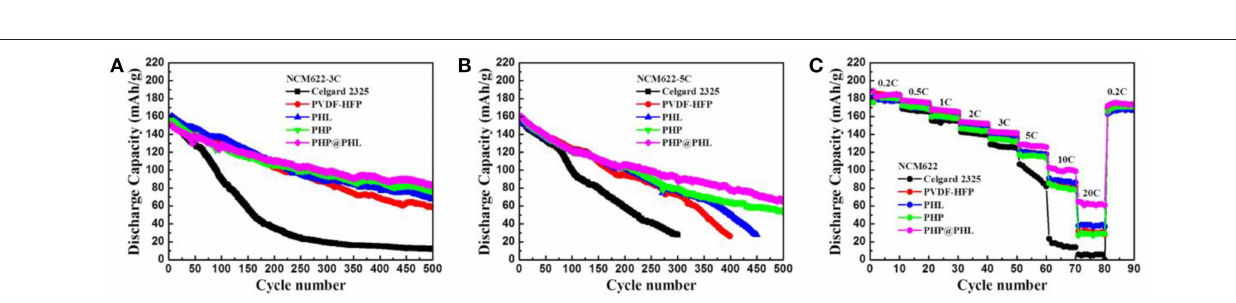
FIGURE 6 | Impedance evolution of the NCM622/Li half-cells with (A) the Celgard 2325, (B) PVDF-HFP, (C) PHL, and (D) PHP@PHL membranes at open circuit potential as a function of storage time at 25 ◦ C for 1, 10, 20, and 30 days.